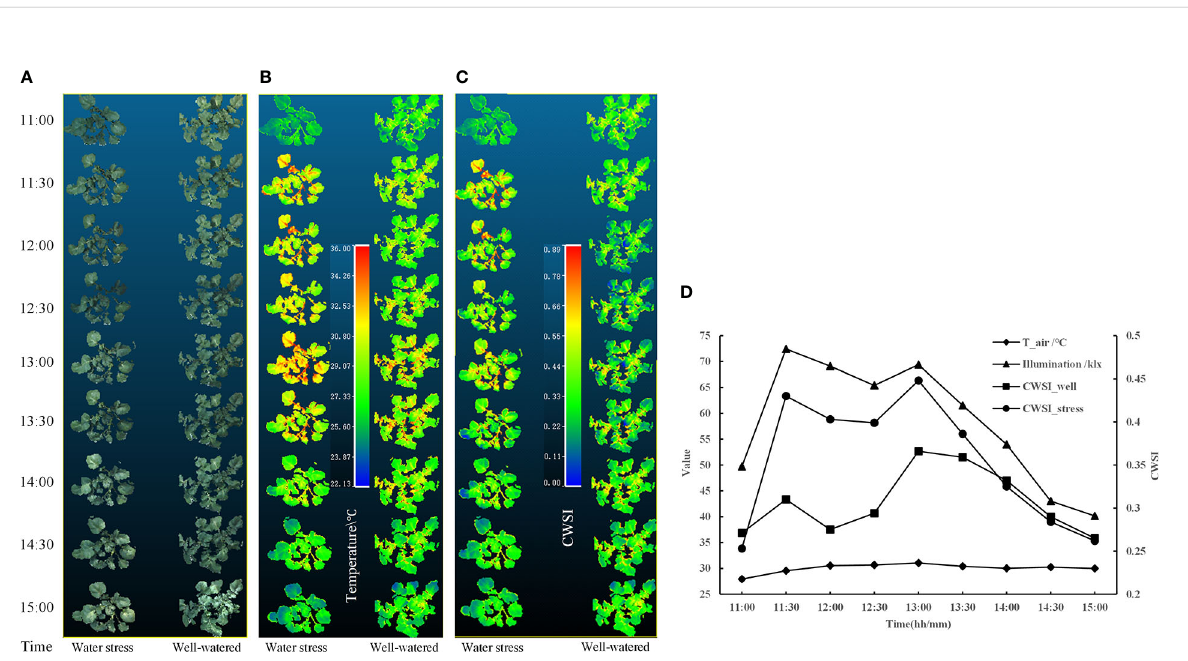
FIGURE 11 At the conditions of under well-watered and water stress, the distributions of the (A) color, (B) temperature, (C) CWSI of two potato samples in 3D,and (D) variation curves of air temperature, illumination intensity, and CWSI of two potato samples.